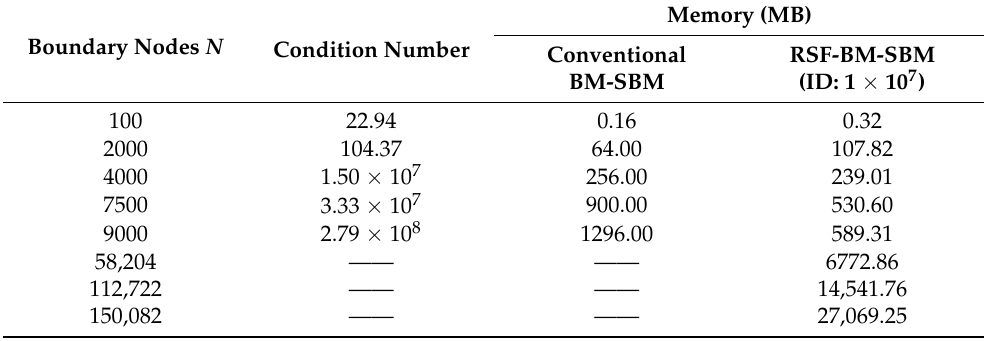
Table 1. Memory and condition number of the RSF-BM-SBM and the BM-SBM with various numbers of nodes.